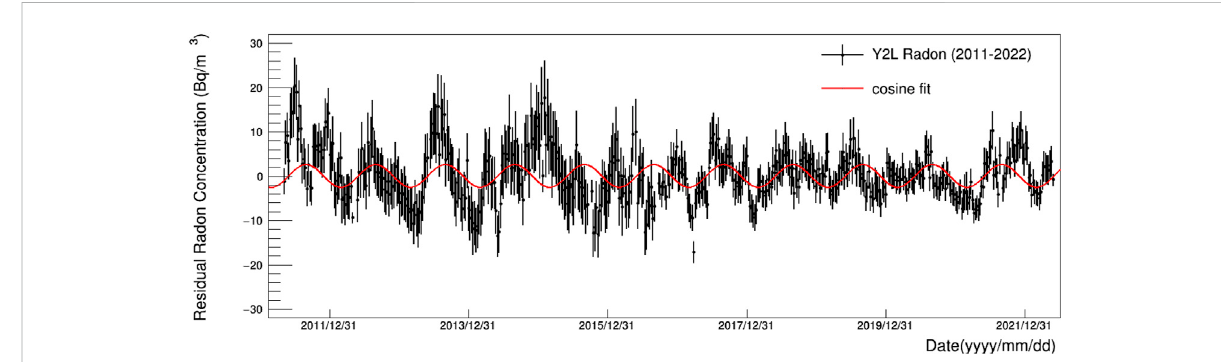
FIGURE 7 The KIMS and COSINE-100 rooms ’ 222 Rn concentration residuals as a function of time are fi t with Eq. 1.